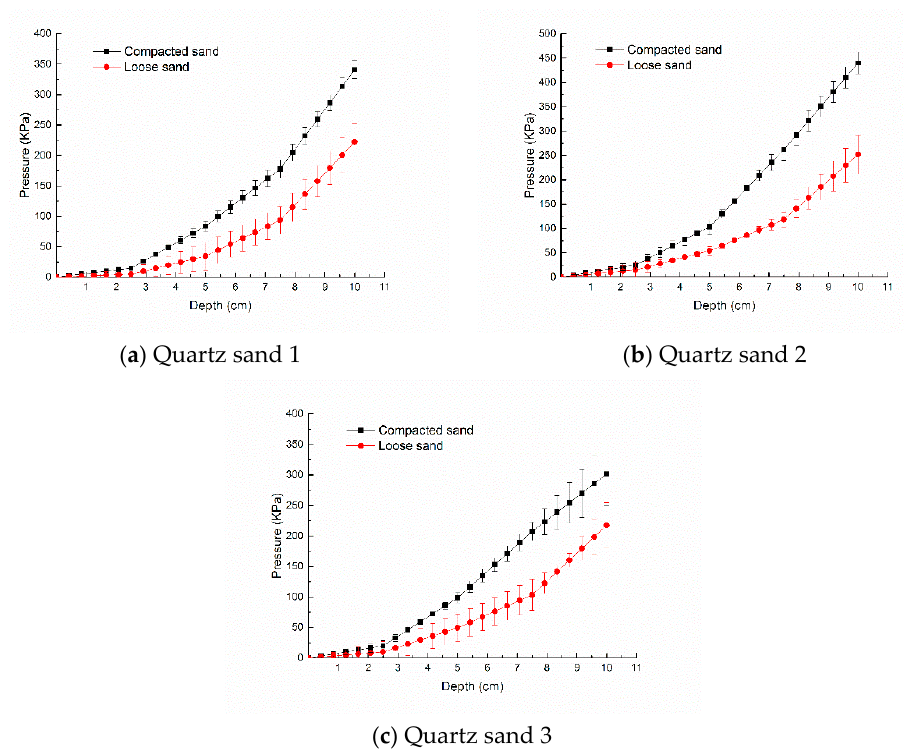
Figure 10. Cone indexes of three kinds of quartz sand.